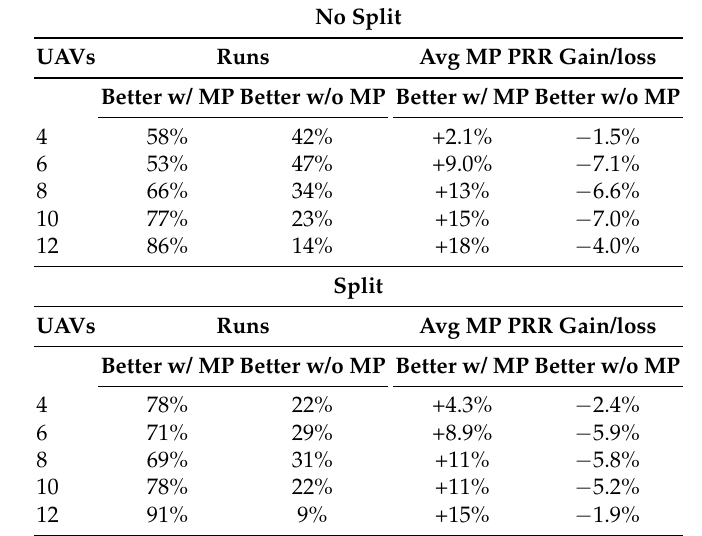
Table 3. Comparison between runs with VSF + CRM + MP and runs with only VSF + CRM.